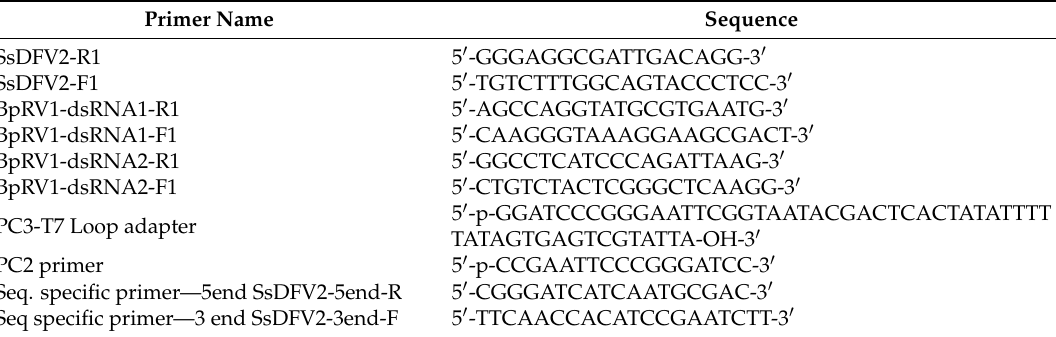
Table 1. Primers used in this